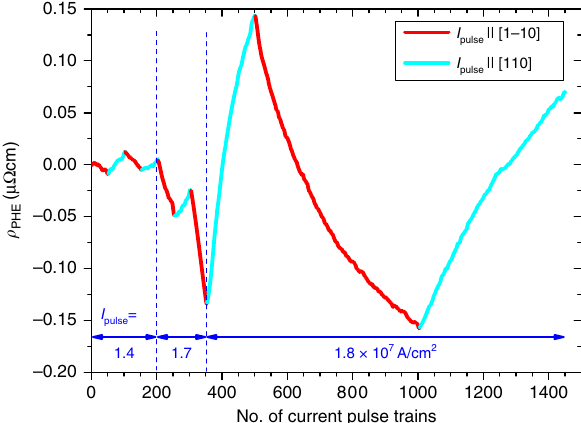
Fig. 2 Current pulse induced heating. Time dependent normalized voltage V Fig. 3 Transversal resistivity. Probed transversal resistivity (DC probing ( t )/ I max measured between the contacts labled I þ current density 10 4 A/cm 2 ) vs. number of applied pulse trains along and V þ during PHE probe application of a current pulse I 1 different directions. The crystallographic direction in which the current with different maximum values I max pulse pulses were injected is indicated by the cyan and red color of the data (Fig. 1). The current pulse induced temperature of our sample is estimated points. The pulse current density was increased from 1.4 × 10 7 to 1.8 × 10 7 from a comparison with the Mn 2 Au temperature dependent resistivity R(T) 17 extrapolated above room temperature A/cm 2 as indicated in the